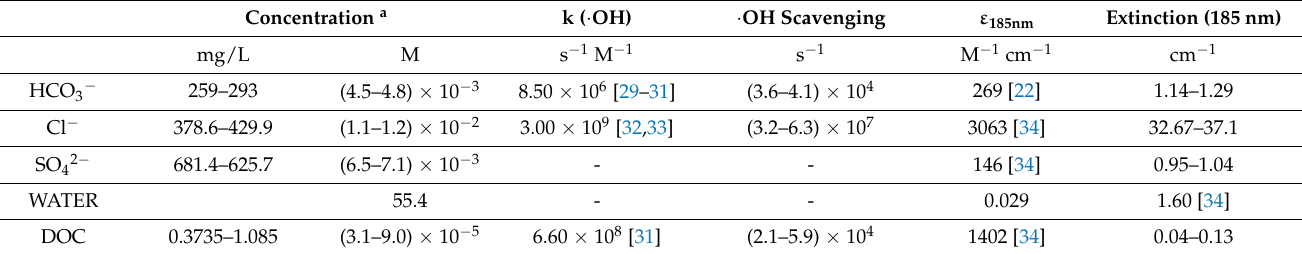
Table 2. The · OH scavenging capacity of the main substances naturally present in